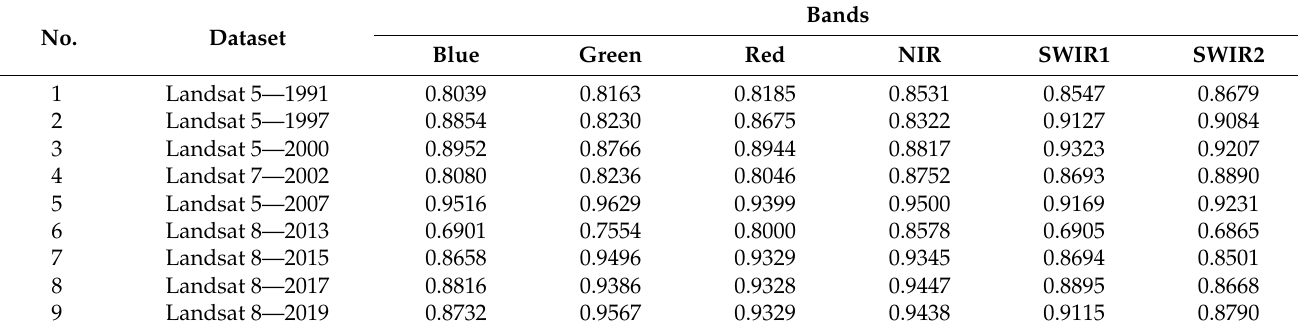
Table A1. Coefficient of determination (R 2 ) values for the selection of PIFs between Landsat 5